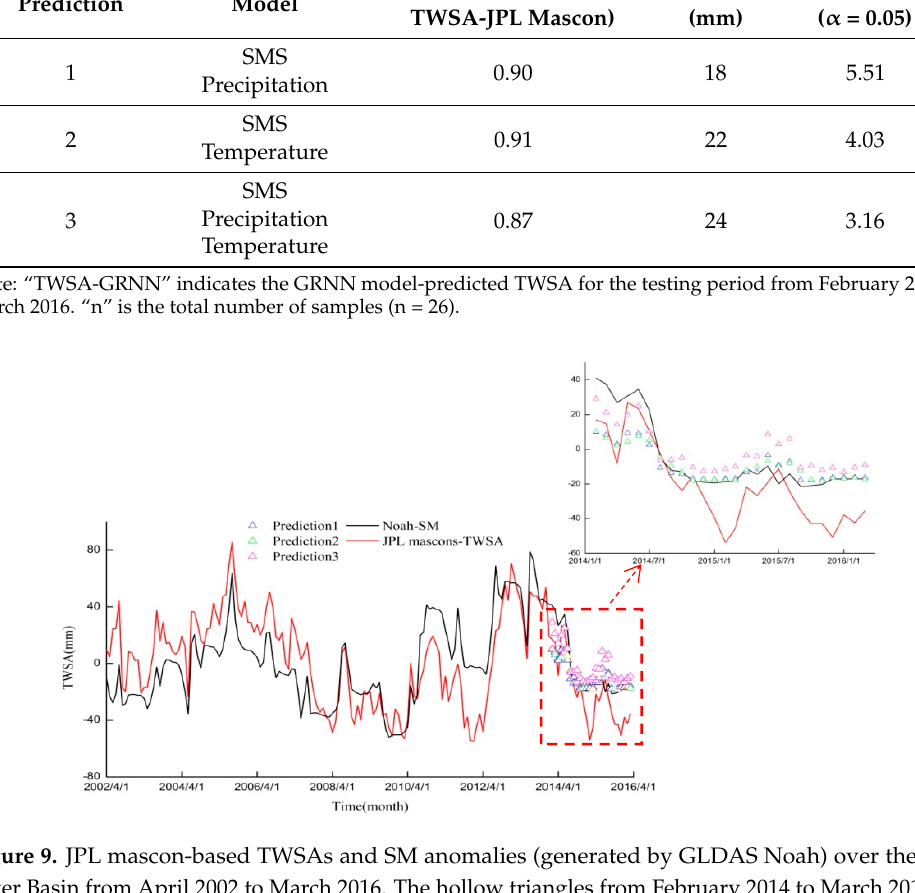
Figure 10. TSD (%) for the Liao River Basin during the period of 1985–2016.